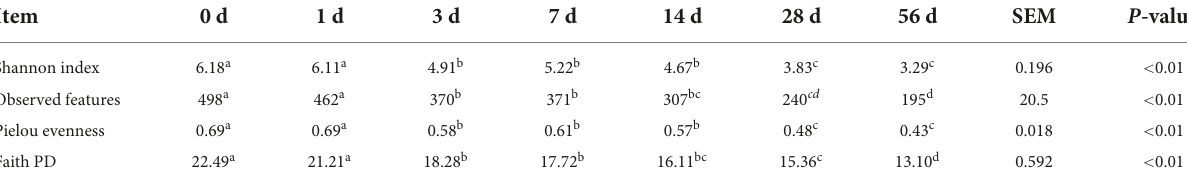
TABLE 3 Variation in the alpha diversity of bacterial community in sorghum stalk silage during ensiling process.